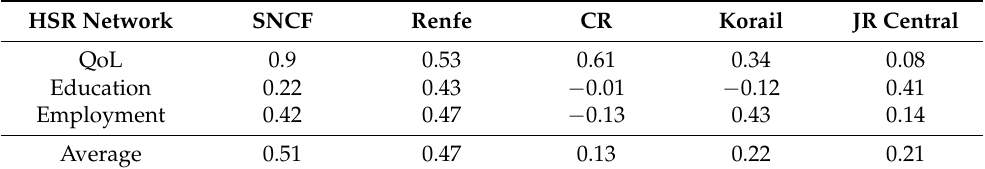
Table 4. The summarisation on PCC results in QoL, education and employment of each HSR network.